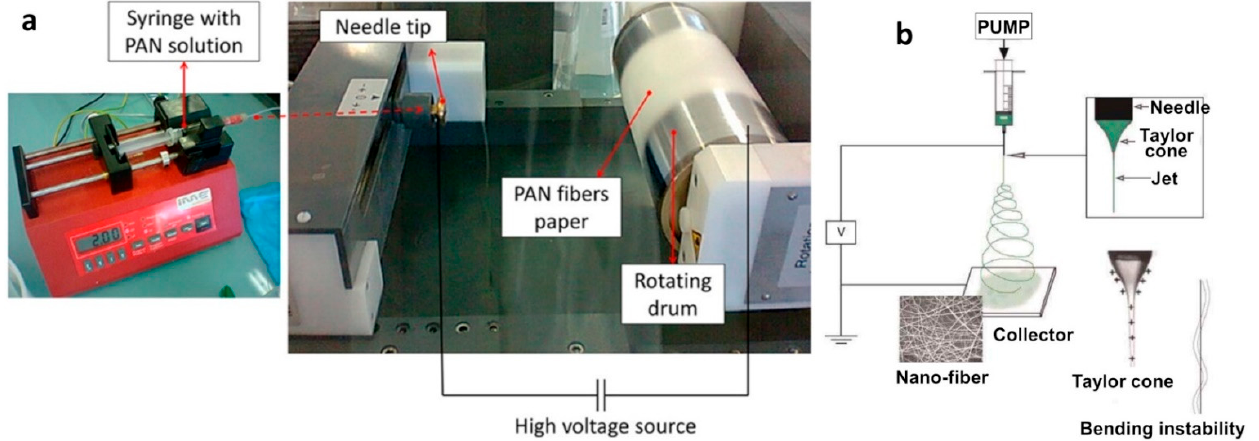
Figure 1. ( a ) Pictures of an electrospinning setup: reprinted and adapted from ref. [54]; Copyright 2015, American Chemical Society, and courtesy provided by Dr. Adriana Both Engel. ( b ) Illustration of the working principle of electrospinning: reprinted and adapted with permission from ref. [55]; Copyright 2015, Elsevier Inc.